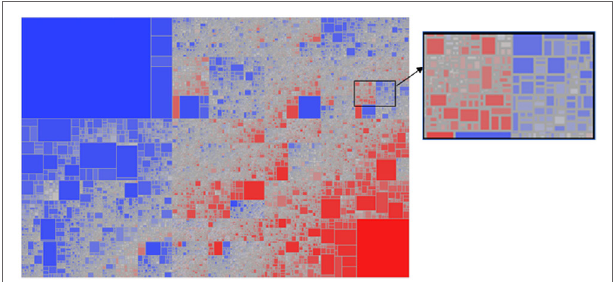
FigUre 1 | Treemap showing the complexity of sharing patterns of T-cell-exposed motifs (TCEMs) (shown for TCEM IIA) among the 17 helminth species analyzed. A total of 112,225 unique sharing patterns were identified. The sharing pattern refers to the combination of the 17 species of helminths that carries that motif. Some sharing patterns comprised a single TCEM motif represented by a very small tile; other sharing patterns comprise large groups of shared motifs and are shown by large tiles. The tiles are colored from highly shared motif groups (blue) to minimally shared motif groups (red). The large blue box at top left represents the TCEM IIA common to all 17 species; the red box at bottom right represents the TCEM IIA absent from all species. The intervening tiles each have a unique combination of motifs and species sharing pattern. The expanded high resolution cutout provides an appreciation of the number and complexity of different patterns embedded in the lower resolution